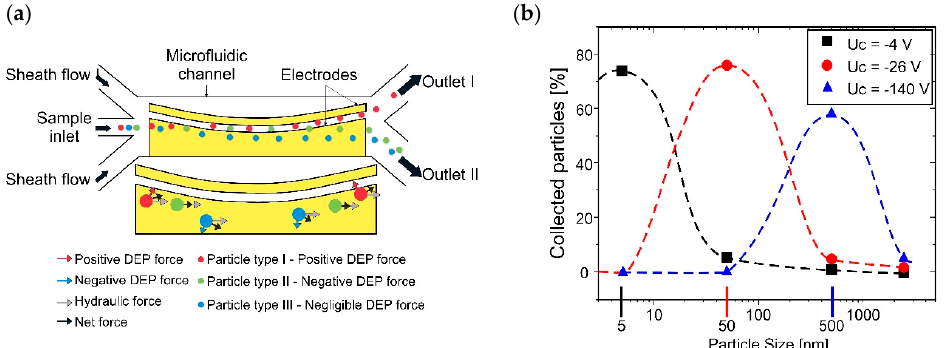
Figure 5. Active separation techniques of selected airborne particles. ( a ) Trajectories of particles under an nDEP force for aerial bacterial isolation. Reprinted with permission from [112]. Copy- right (2009) American chemical Society. ( b ) FEM simulation of positive charged NP sampling effi-